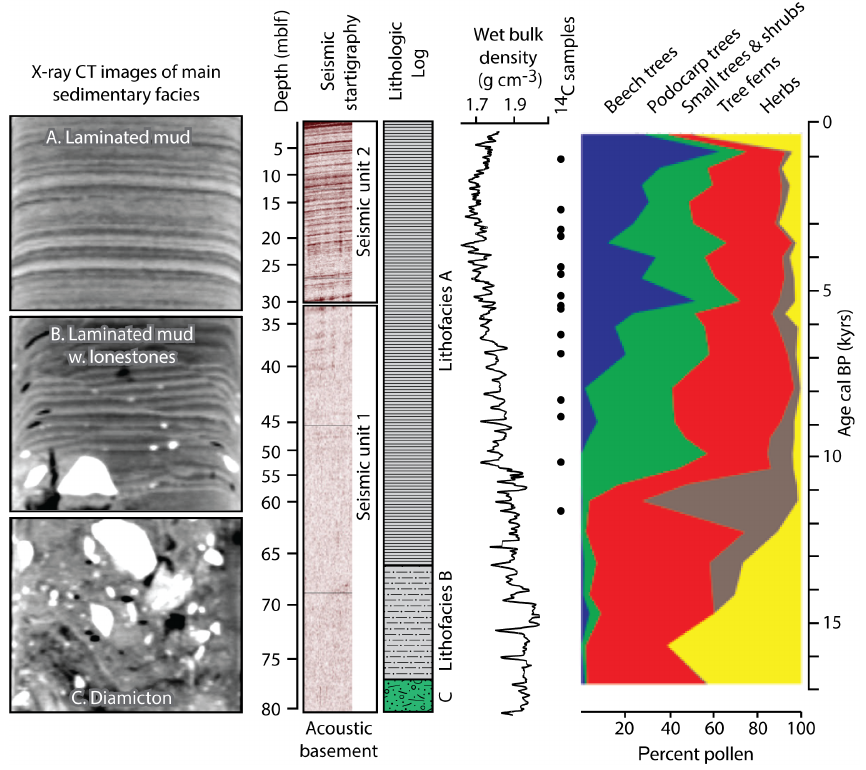
Figure 6. X-ray CT images of three primary facies recovered at LOCH-1 and -2. Seismic facies, basic stratigraphic column, and smoothed wet bulk density data from LOCH-1. Density minima every 1.5–3m indicate core/section breaks. Pollen changes observed in core catcher samples from LOCH-1 showing a LGM to Holocene vegetation transition consistent with that observed at other sites in New Zealand. Preliminary 14 C samples (black dots) and associated age data align well with the age distribution inferred from pollen